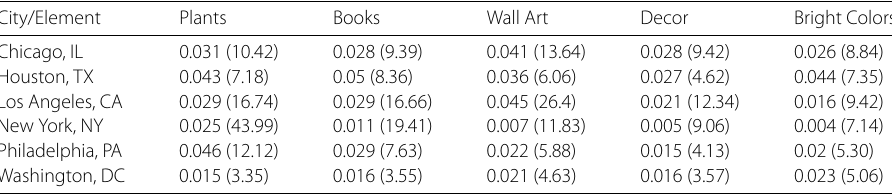
Table 4 Combined Moran’s I and z-score statistics for element clustering in selected U.S. cities City/Element Plants Books Wall Art Decor Bright Colors Chicago, IL